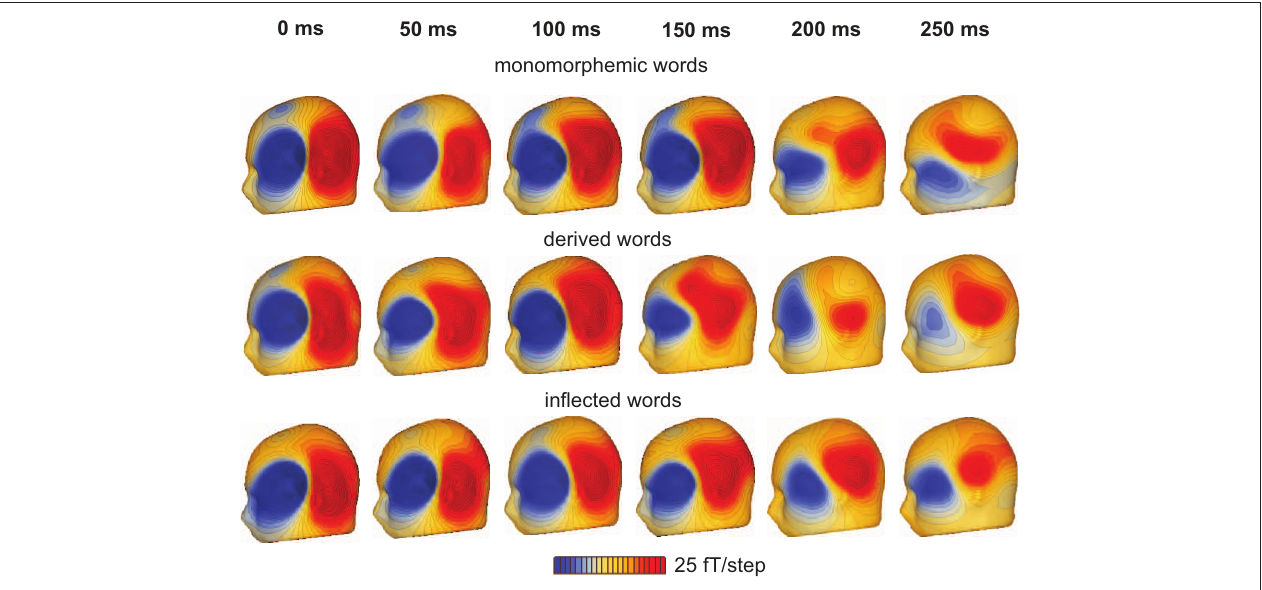
FiGuRE 1 | Grand average magnetic flux patterns for monomorphemic, derived, and inflected words for 0–250 ms after the critical point presented in 50 ms time steps (magnetic flux density 25 ft/step). Blue indicates magnetic flux directed into the brain (negative flux), while red shows flux directed out of the brain (positive